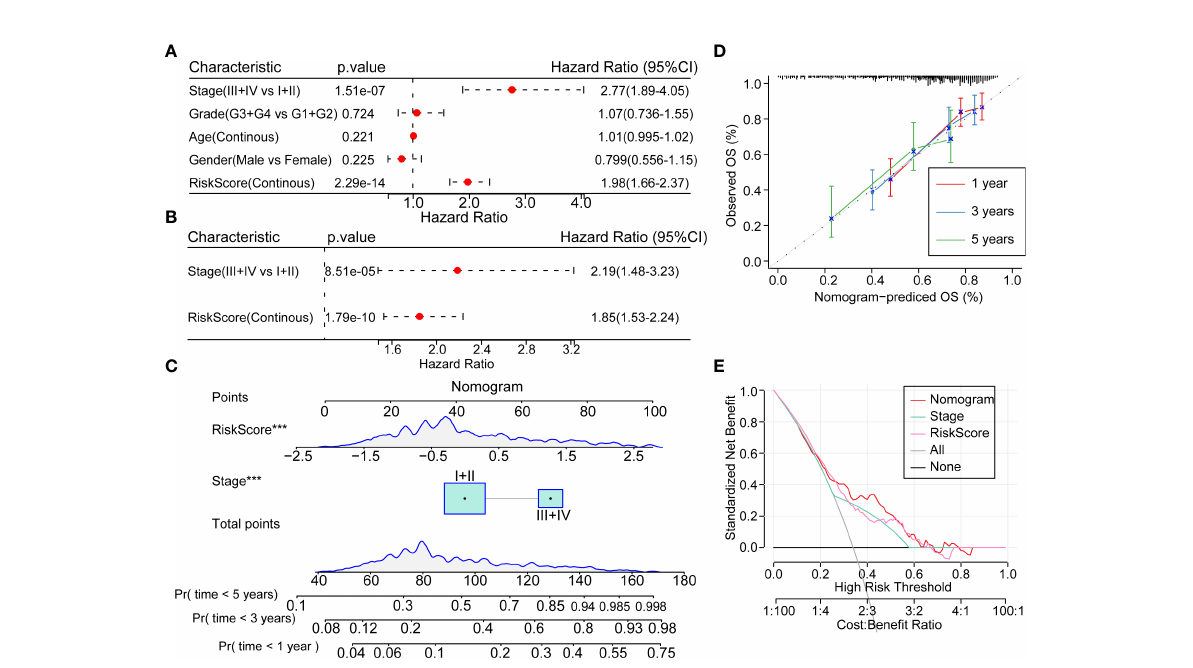
FIGURE 8 Prognostic model modi fi cation based on clinical features (A, B) . Univariate and multivariate cox analysis of risk-score and clinicopathological features (C) Nomogram showing the patient risk assessment and probability of survival in combination with the risk score and clinical characteristics. (D) Calibration curves of the 1, 3 and 5 years of the line graph. (E) Decision curve of the line graph.